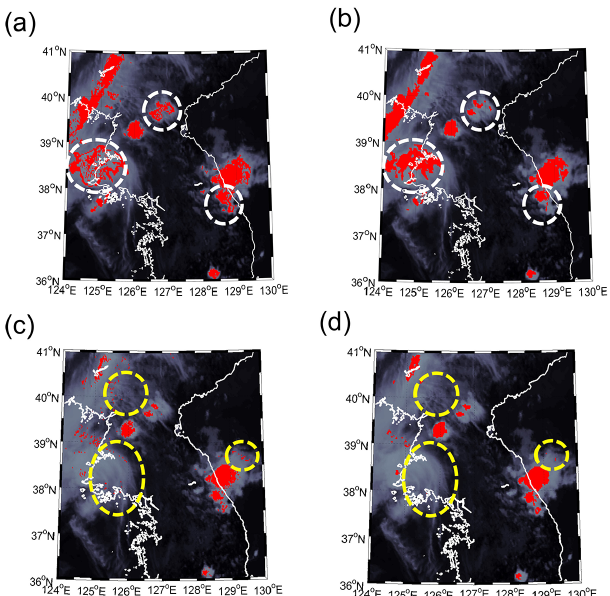
Figure 4. Before and after postprocessing of CI cloud objects using majority voting and region growing. (a) An example of determinis- tic CI detection generated by DT before postprocessing. (b) Deter- ministic CI detection generated by DT after postprocessing. (c) De- terministic CI detection generated by RF before postprocessing. (d) Deterministic CI detection generated by RF after postprocess- ing. While dashed white circles show that region growing made CI objects more compact with few holes, dashed yellow circles show that majority voting effectively removed salt-and-pepper